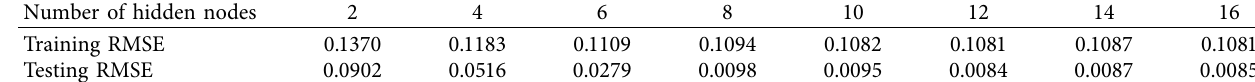
Table 4: The influence of hidden node number on BACS − ELM algorithm.